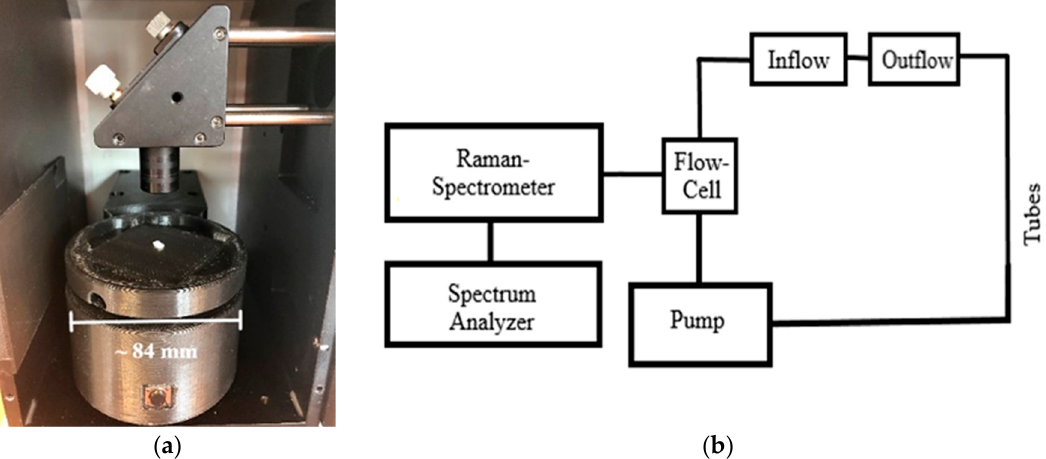
Figure 17. ( a ) Rotary table for the detection of MP particles, ( b ) scheme of the experimental setting for real ‐ time detection of MP in streaming water under different flow behavior.